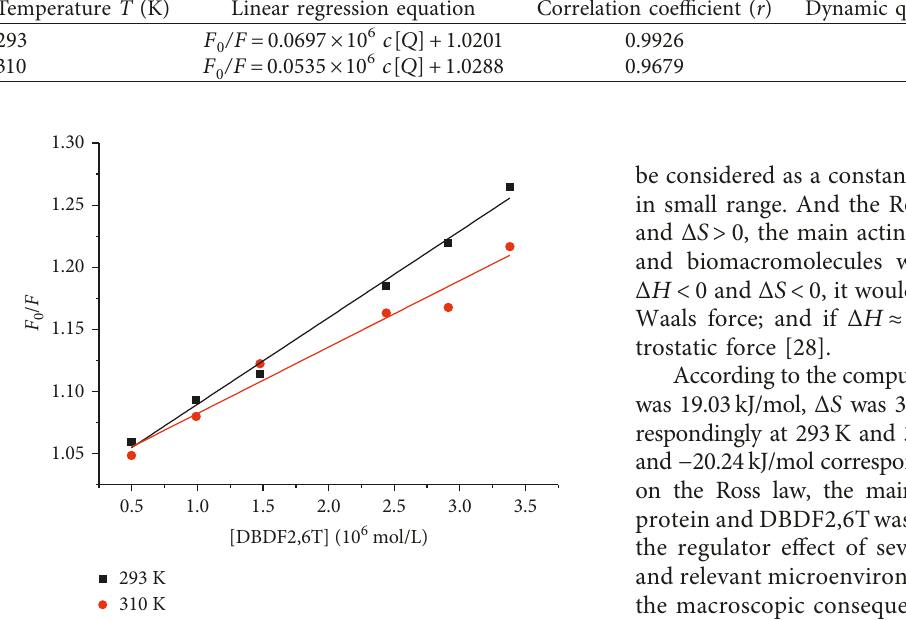
Figure 3: Stern–Volmer plots of hPPAR c interacted with DBDF2,6T at different